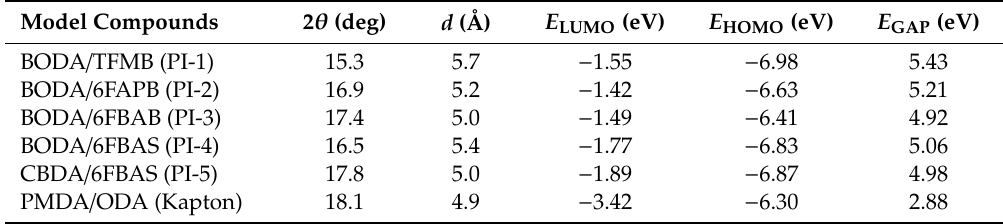
Table 6. WAXD data and molecular orbital energies of semi-alicyclic polyimides. Model